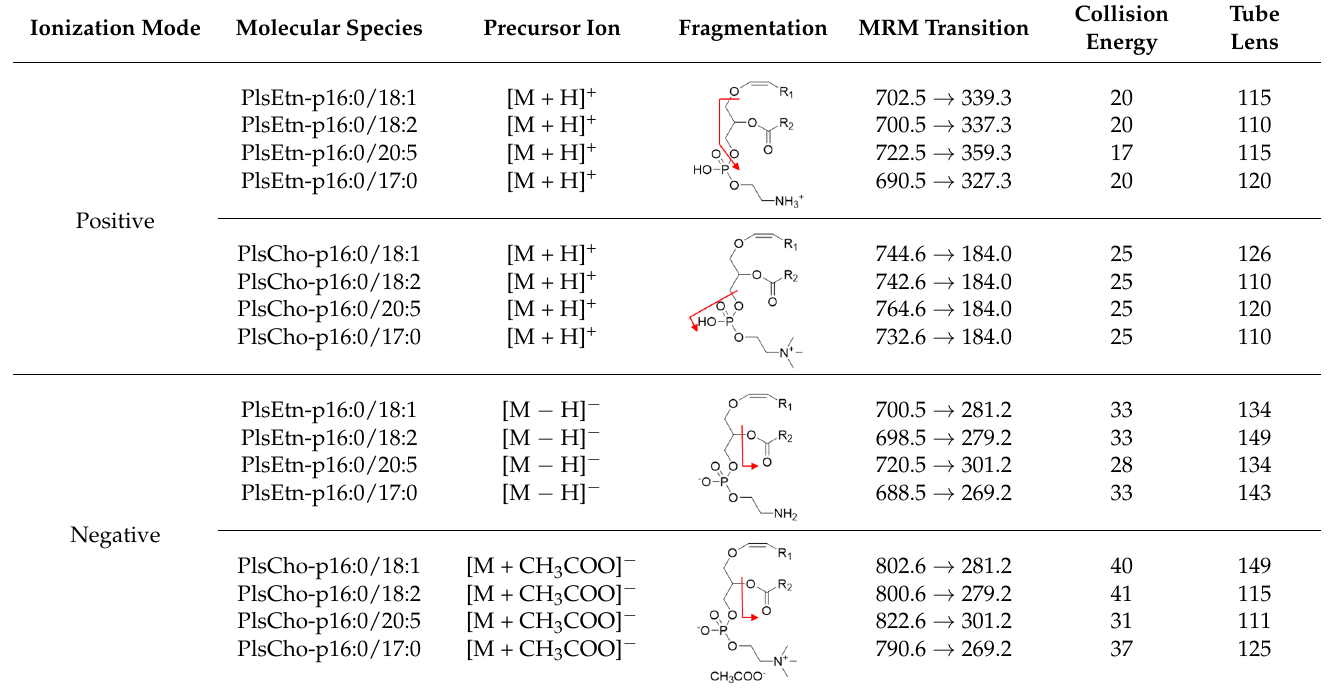
Table 2. MRM parameters in positive and negative modes.